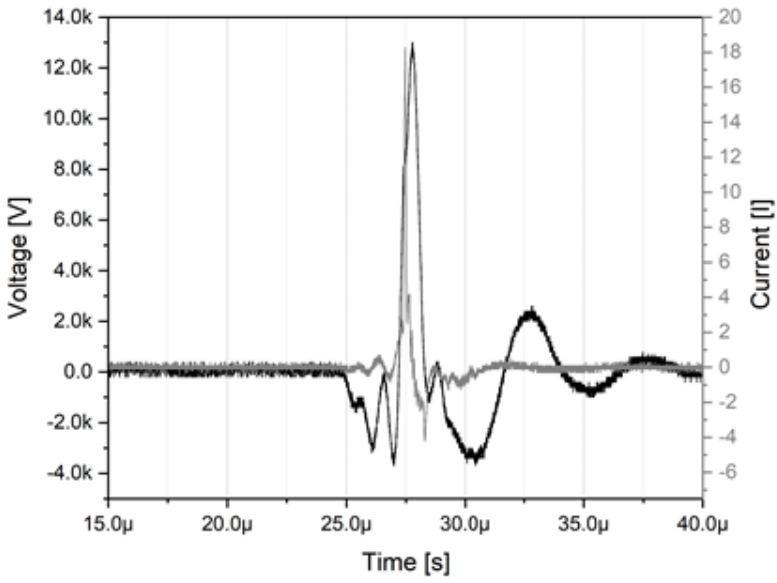
Figure 2. U–I–characteristics of the plasma source at a power of approx. 400 Figure 2. U – I – characteristics of the plasma source at a power of approx. 400 W.